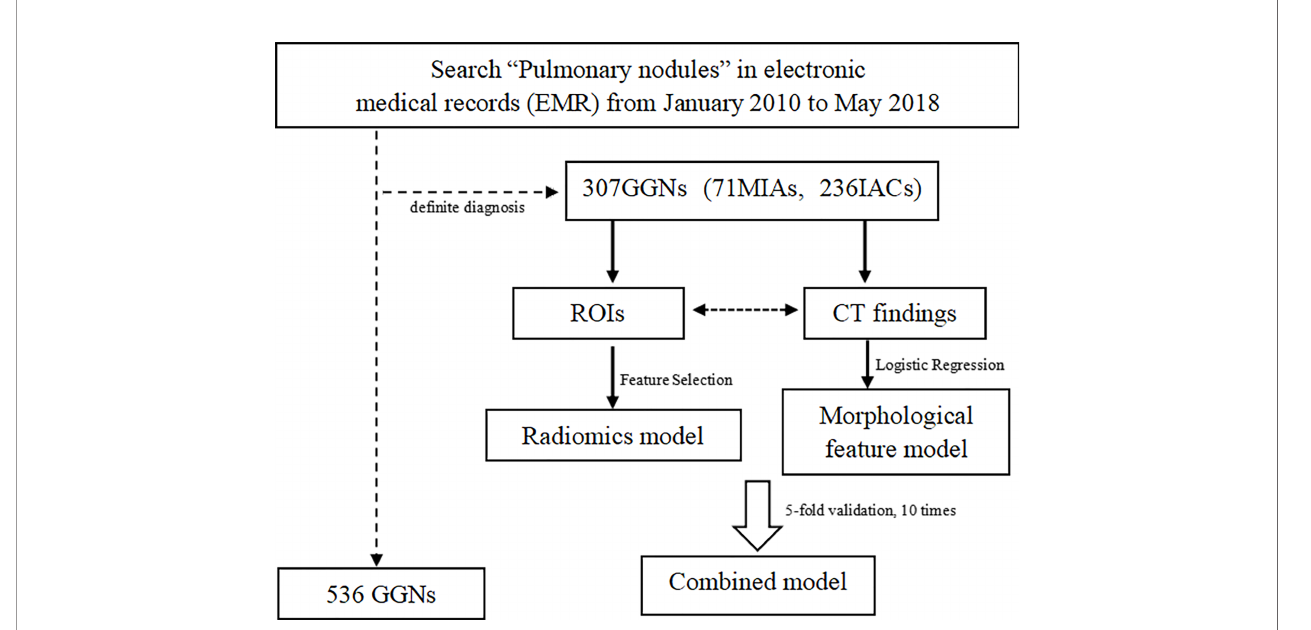
FIGURE 1 | Flow diagram of the